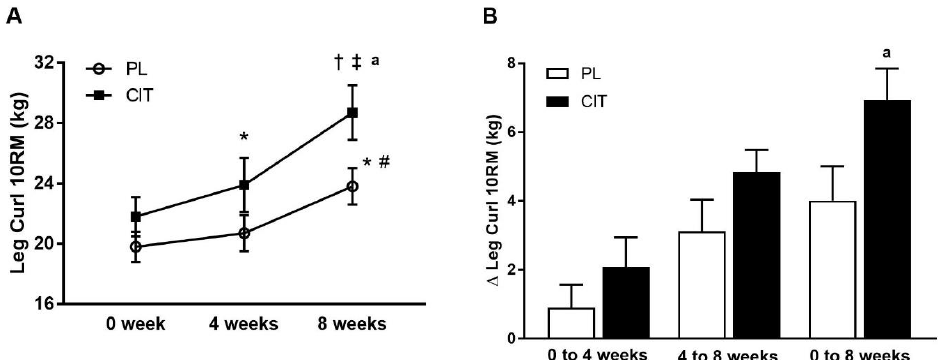
Figure 5. Legs lean mass (LM) ( A ) at 0 week, after 4 weeks (CIT supplementation alone), and after 8 weeks (CIT and SVLIRT combined) and changes ( ∆ ) in legs LM ( B ) from 0 week to 4 weeks, from 4 weeks to 8 weeks, and from 0 week to 8 weeks compared to the PL in postmenopausal women. † p < 0.001 vs. 0 week; # p < 0.05 vs. 4 weeks; a p < 0.05 vs. PL; b p < 0.001 vs. PL.